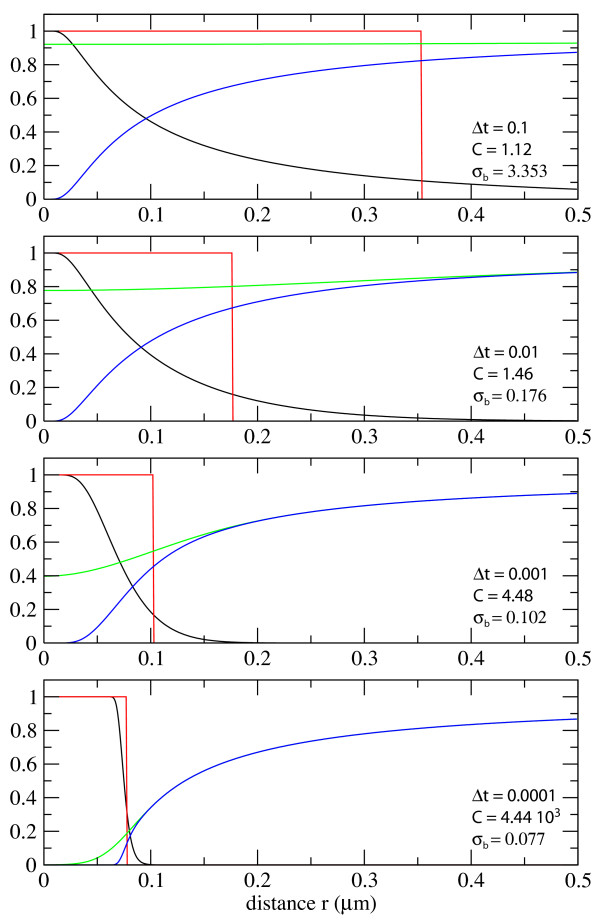
Radial probability densities and the correction factor C. The radial probability distribution, ρB, before interaction with A (green), and after (blue). The blue distribution evolves to the green distribution after one step of diffusion. The probability of interaction is shown in black. The probability of interaction as given by the corrected Smoluchowski approach of Andrews and Bray is also shown in red (P(r) = 1 for r <σb). Four timesteps are shown: Δt = 0.1s, 0.01s, 0.001s, 0.0001s. The correction factors and corrected Smoluchowski binding radii, σb, corresponding to the different timesteps are also shown, k = 106 M-1s-1, and DA = DB = 1 μm2s-1.